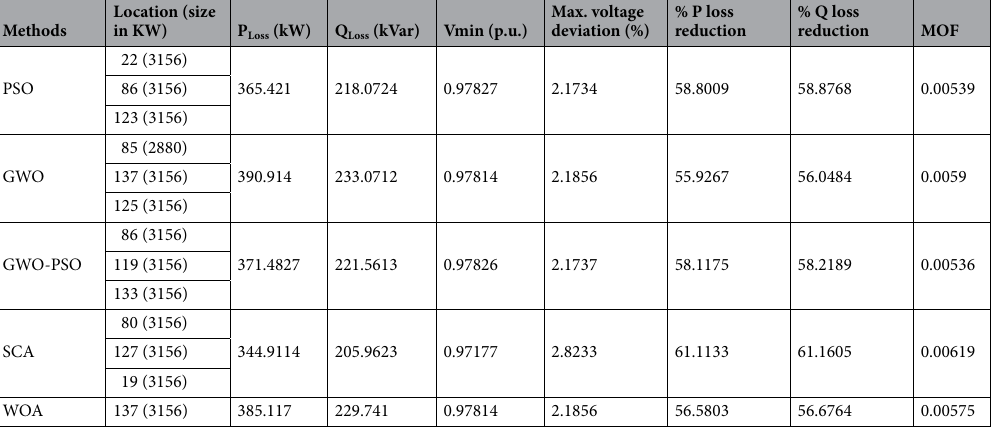
Table 5. Performance measurement after 3-DG integration with different algorithms.